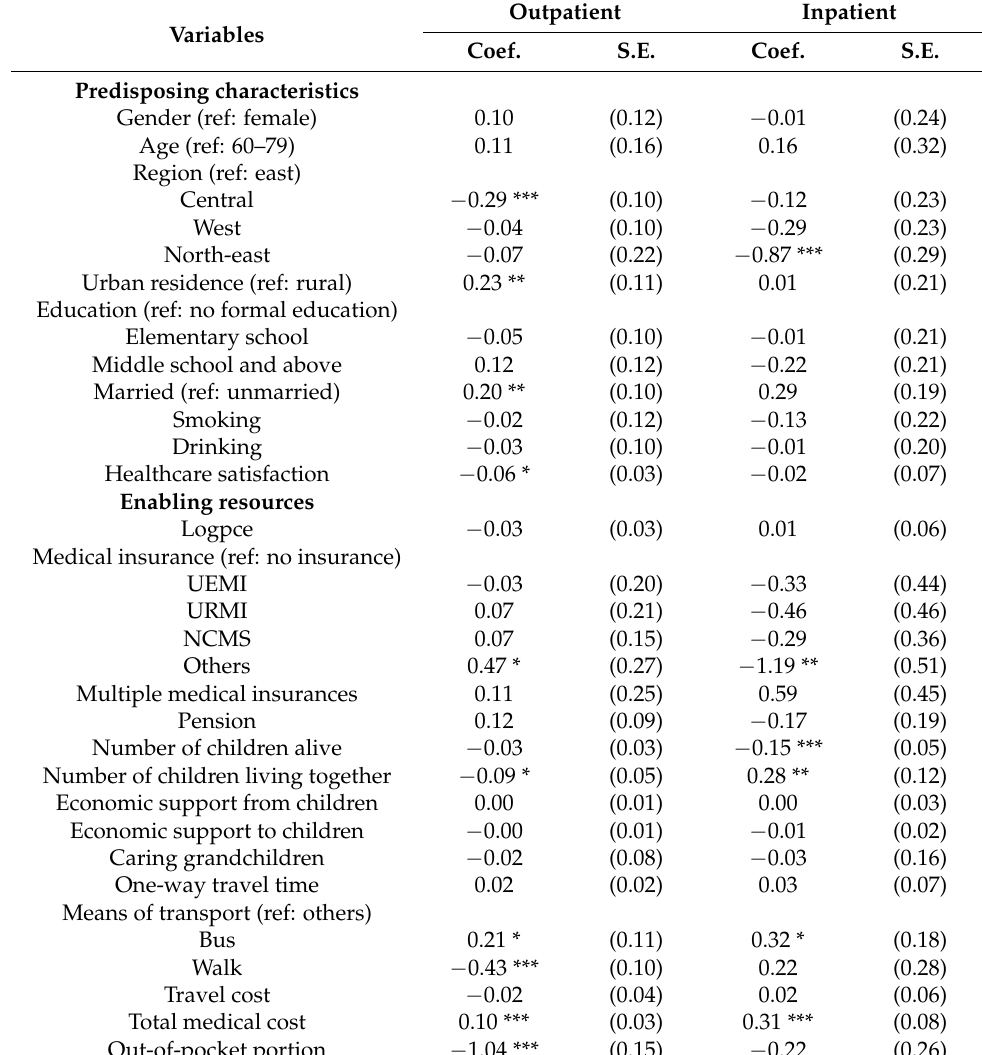
Table 4. Results of the probit regression model on the determinants of visiting public health- care providers. Outpatient Inpatient Variables Coef. S.E. Coef.